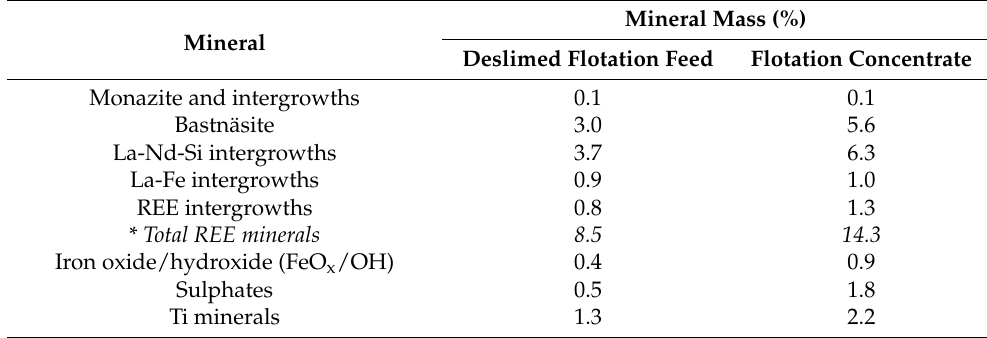
Table 7. Mineralogical composition of deslimed flotation feeds and